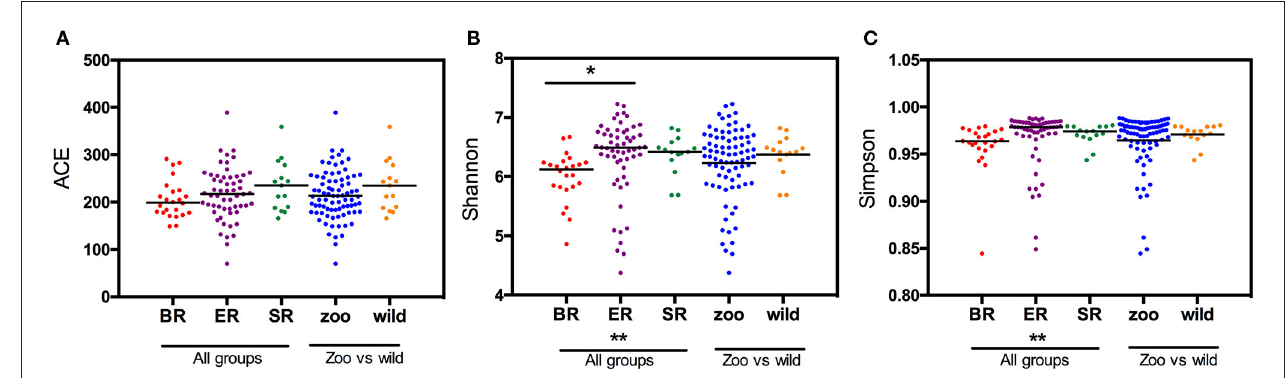
FIGURE 1 | Estimated OTUs richness and diversity index in different groups of monkeys. The index of OTUs richness in different groups was estimated using ACE (A) metrics. To estimate OTU diversity, Simpson’s index (B) and Shannon’s index (C) were performed. No significant statistical differences in ACE ( p = 0.23) between the three groups was obtained using Kruskal-Wallis tests. Statistically significant differences were found between ER and other groups ( p < 0.05) using the Simpson and Shannon metrics.